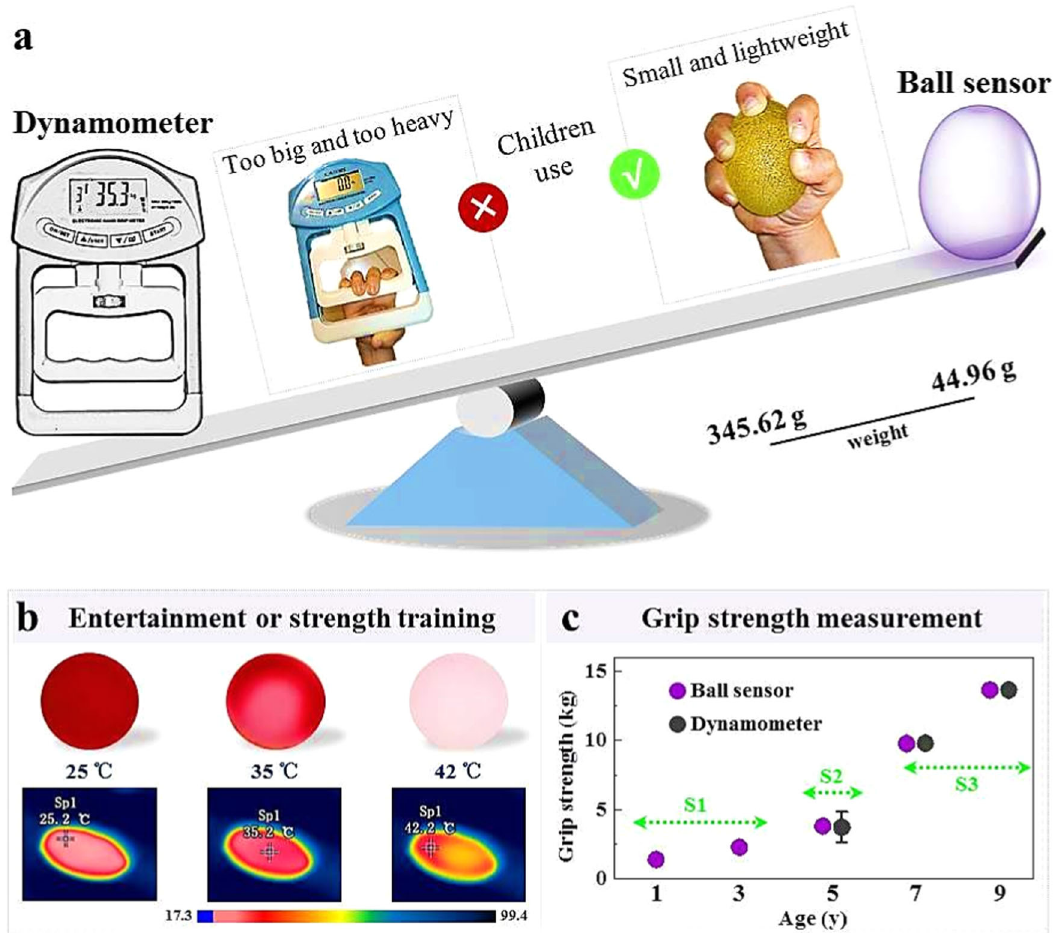
Fig. 7 On-body validation for children. a Comparison of volume and weight between commercial grip instrument and our ball sensor. Our ball sensor is small and lightweight enough for better grasping by children ’ s small hands. b Additional function of the smart ball sensor. The temperature sensitive layer of the ball can respond to thermal stimulus in color change, which can appeal to children for entertainment or strength training. c Comparison of the monitoring performances. There is rarely miniaturized customization of commercial grip instruments for children under 7 years old that can hardly grasp the big and heavy dynamometer by their small hands, so the adult design of the commercial grip instrument cannot get these children ’ s grip data (S1 stage) or only get inaccurate results (S2 stage). In comparison, our smart ball sensor is powerful for a wide range of grip monitoring. It can not only detect big grip strength of children over 7 years old (S3 stage), same with commercial grip instruments, but also recognize the small grip strength of infants under 7 years